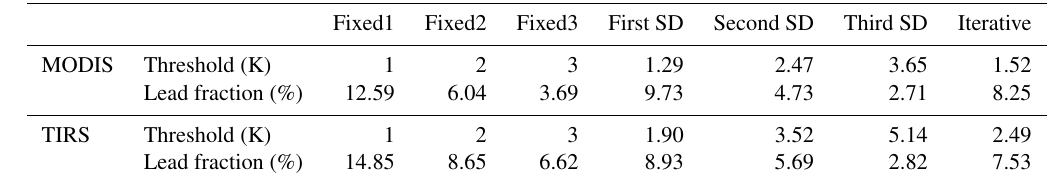
Table 4. Threshold candidates for lead detection and corresponding lead fractions. Fixed1 Fixed2 Fixed3